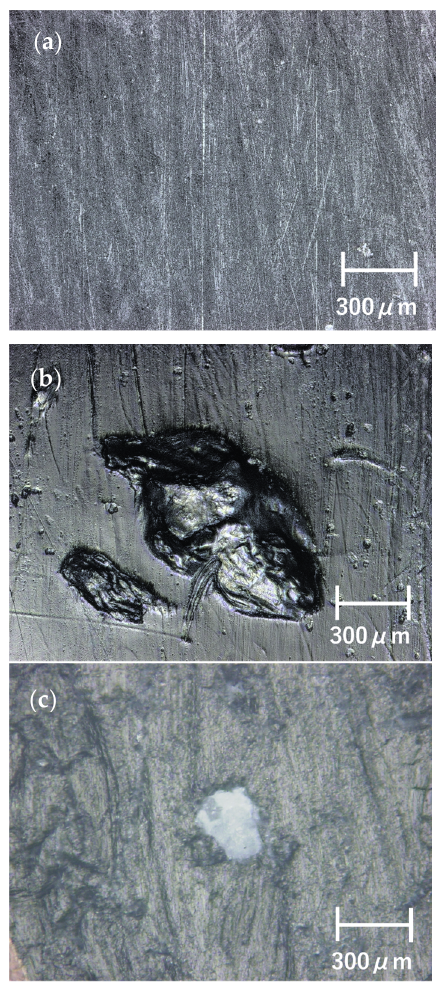
Figure 4. Optical micrographs of retrieved ultra-high-molecular-weight polyethylene. ( a ) Burnishing, ( b ) pitting, and ( c ) embedded debris.